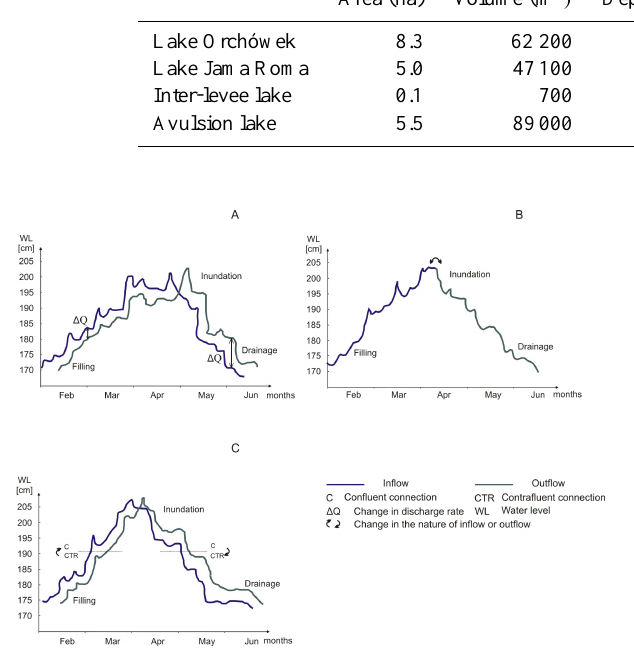
Fig. 3. Hydrographs of floodplain lakes under study depending on the connection to the Bug River: (A) – confluent lakes, (B) – con- trafluent lakes, and (C) – contrafluent–confluent lakes.